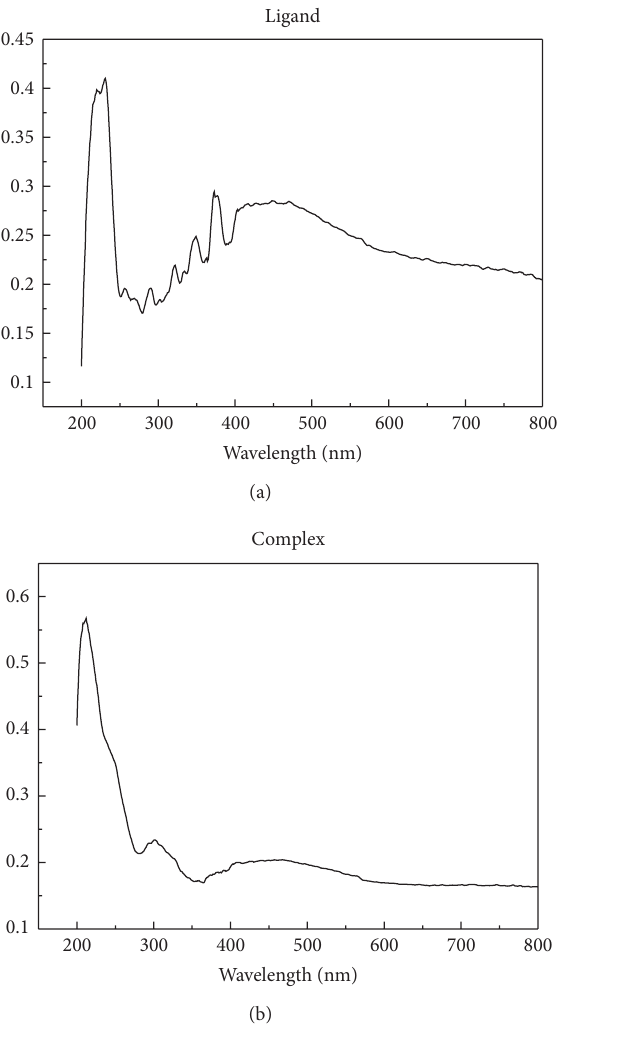
Figure 2: FT-IR spectra of H 3 L-MA and